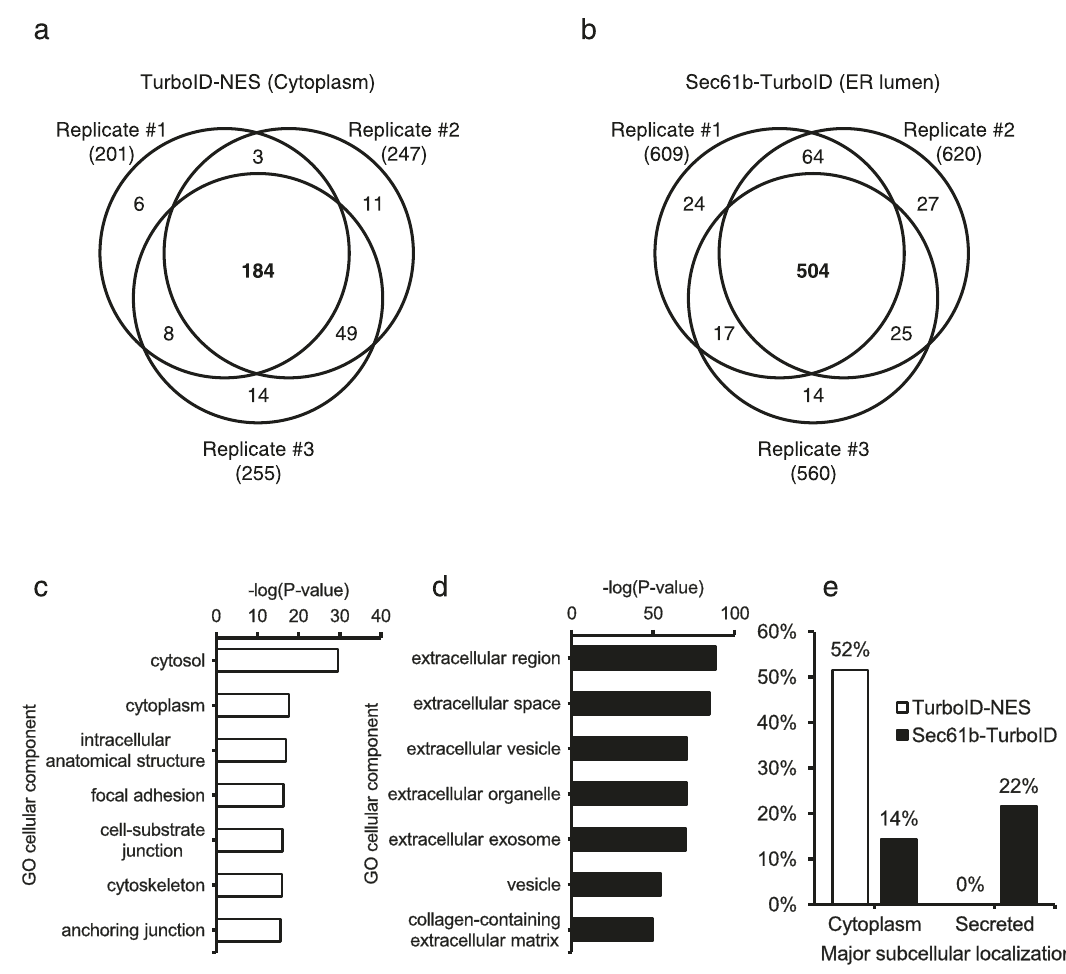
Fig. 2 Proteomic validation of secretory protein labeling using ER-anchored TurboID. a , b Venn diagrams depicting biotinylated proteins with more than two biotinylated spectral counts for each biological replicate in the culture supernatant of HEK293 cells expressing TurboID-NES ( a ) and Sec61b-TurboID ( b ), respectively. c Gene Ontology (GO) analysis of detected proteins in the culture supernatant of HEK293 cells expressing TurboID-NES. d Gene Ontology (GO) analysis of detected proteins in the culture supernatant of HEK293 cells expressing Sec61b-TurboID. e Fraction of cytoplasmic and secreted proteins in the culture supernatant of HEK293 cells expressing TurboID-NES or